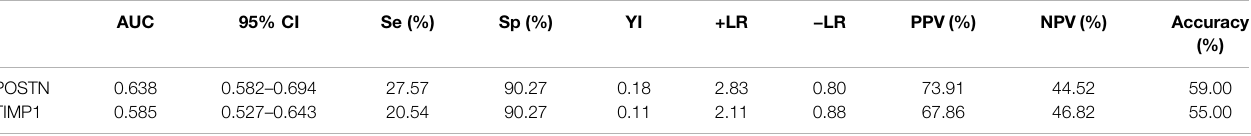
TABLE 2 | Diagnostic value of anti-POSTN and anti-TIMP1 autoantibodies in diagnosing ESCC